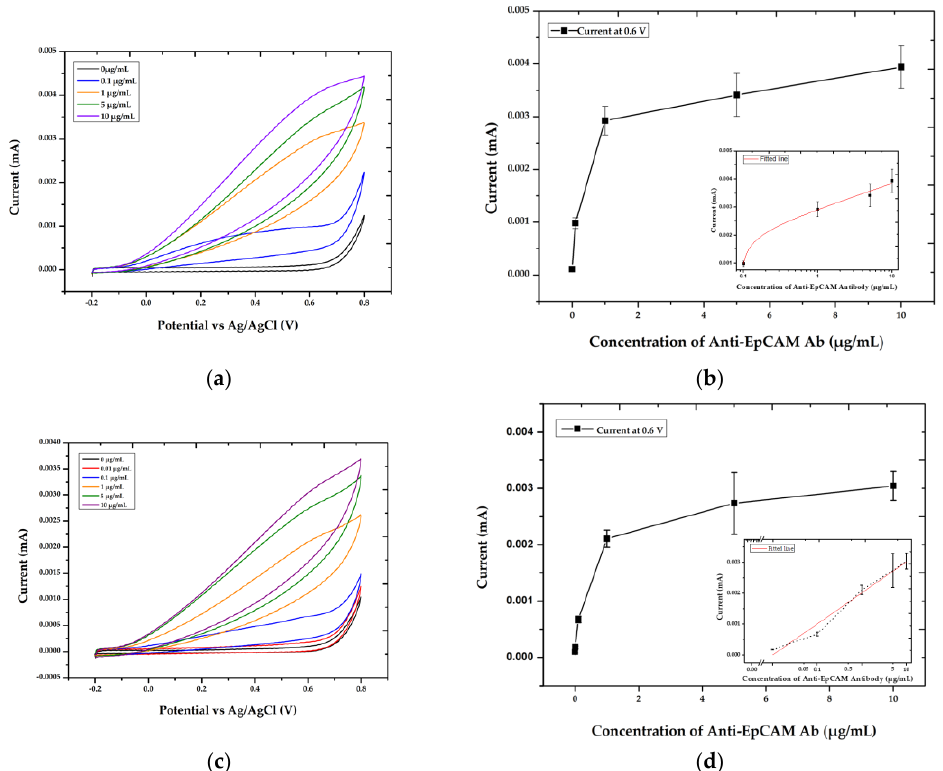
Figure 4. Cyclic voltammetry (CV) recorded (from − 0.2 to 0.8 V) after an incubation period of 2 min at immunosensing electrodes treated with various concentrations of biotinylated anti-EpCAM mouse IgG antibody in PBS ( a ) and in 90% human plasma ( c ) in the developed AMB-based ITO platform. Anti-mouse IgG ab labeled with ALP was utilized for signaling. ( b , d ) Current values for the tested samples at 0.6 V were recorded in Figure 4a,c, respectively. Data = mean ± standard deviation, n = 3. As shown in the insets, all the data could be fitted using a linear line when plotting the X-axis in log-scale. The data were well-fitted with R 2 of 0.99 in PBS for ( b ) and with R 2 of 0.98 in 90% of human plasma for ( d ).